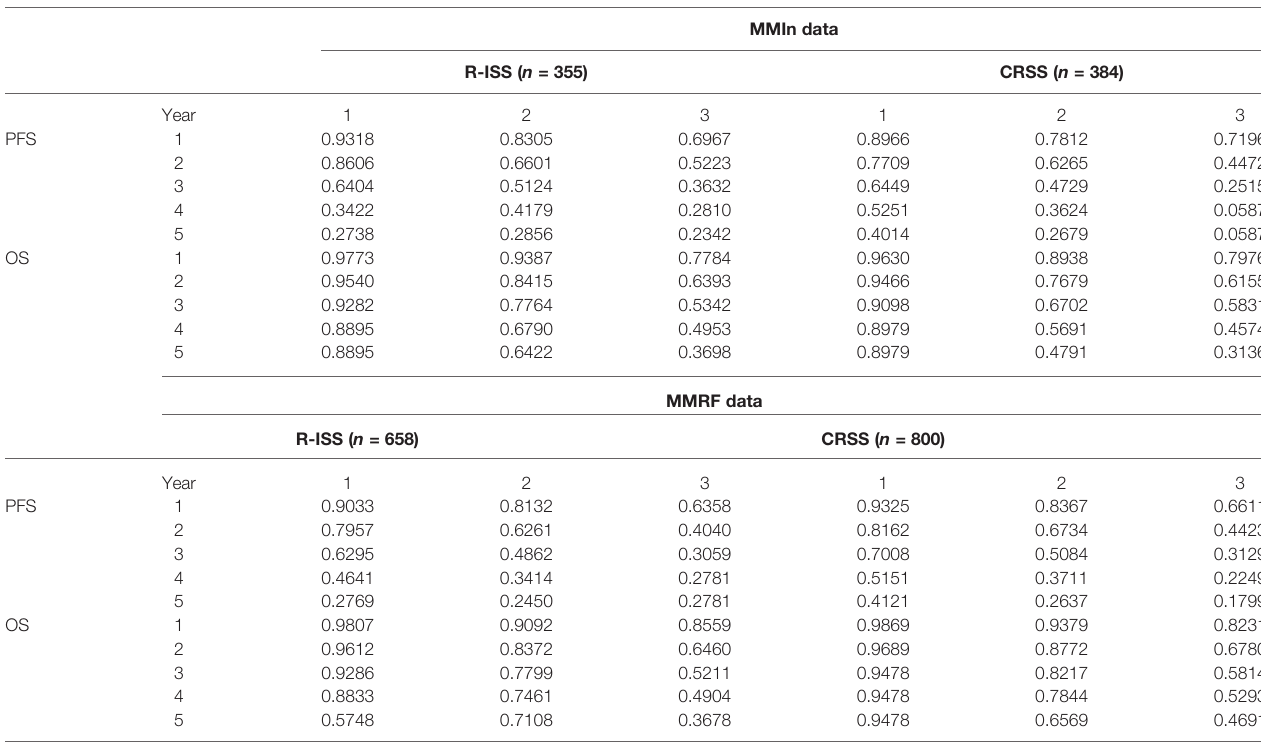
TABLE 3 | Prediction of progression-free survival and overall survival (in %) for CRSS and R-ISS at 1, 2, 3, 4, and 5 years in the MMIn ( n = 384) and MMRF datasets ( n =